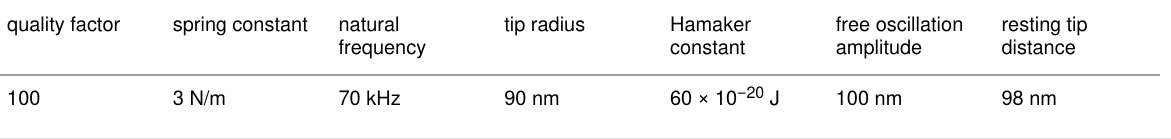
Table 1: Simulation parameters for the spring–mass–dashpot AFM model in the attractive imaging regime (i.e., without tip–sample contact). The tip–sample interaction forces are modelled using the Hamaker equation for the case of a sphere interacting with a flat surface [42]. The imaging pa- rameters are selected to resemble day-to-day large-amplitude experiments. The cantilever properties are similar to those of commercial cantilevers (e.g., BudgetSensors, ElectriMulti75-G conductively coated KPFM cantilevers). The Hamaker constant is chosen within the range appropriate for ma- terials used in AFM experiments [46].